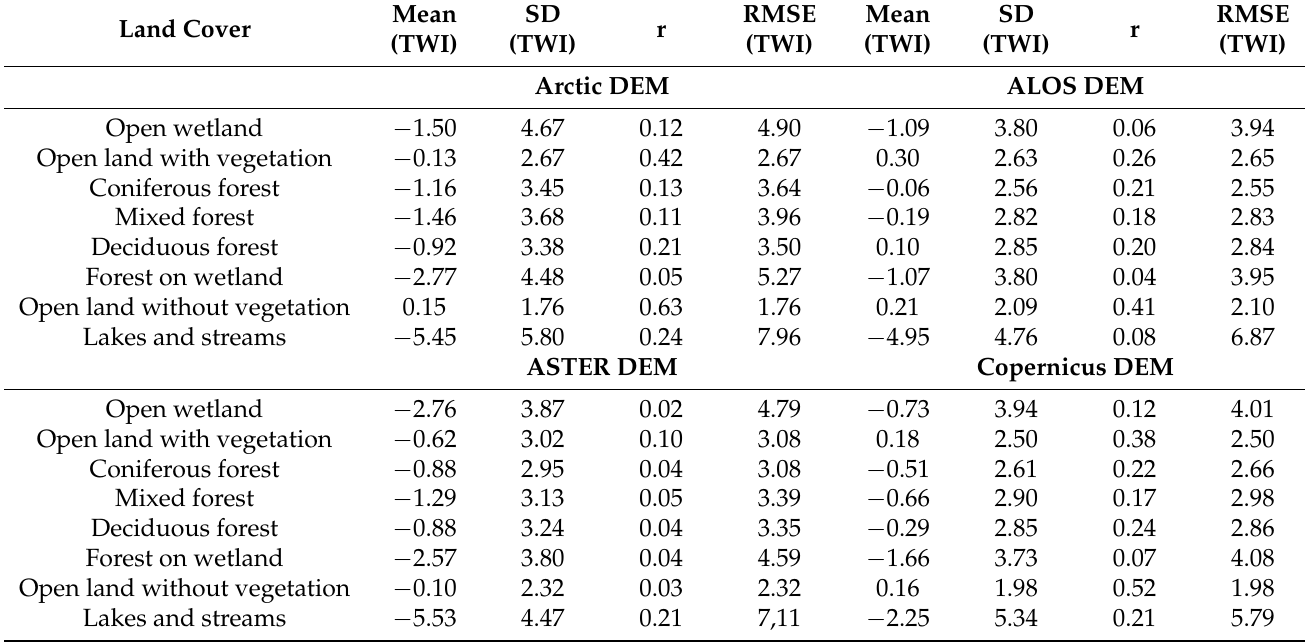
Table 6. TWI error for four candidate DEMs in eight land cover classes. Correlation between TWI and terrain slope differed marginally between candidate DEMs and is not reported.